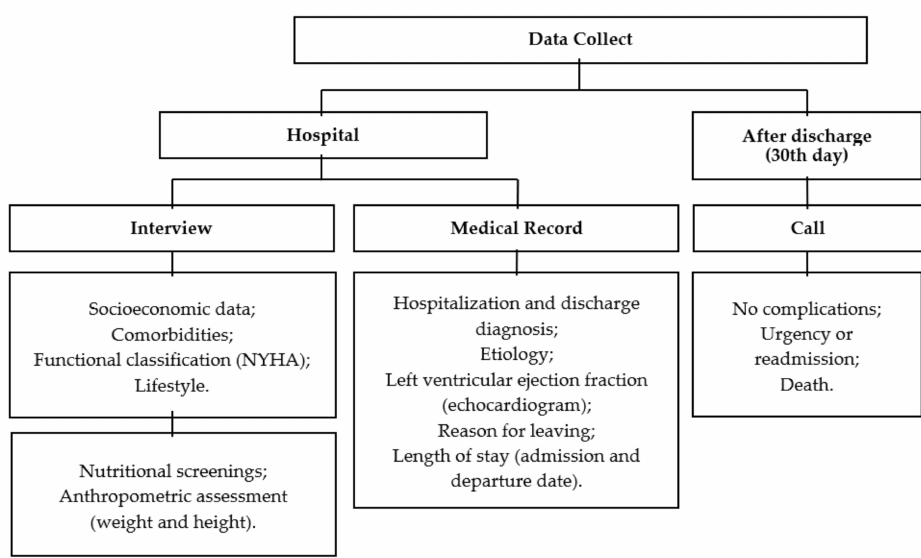
Figure 1. Description of data collection